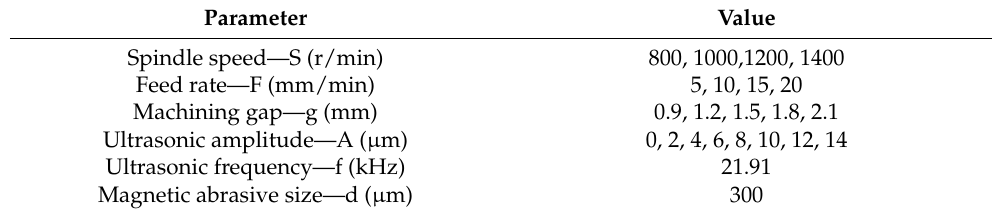
Table 2. Machining parameters.